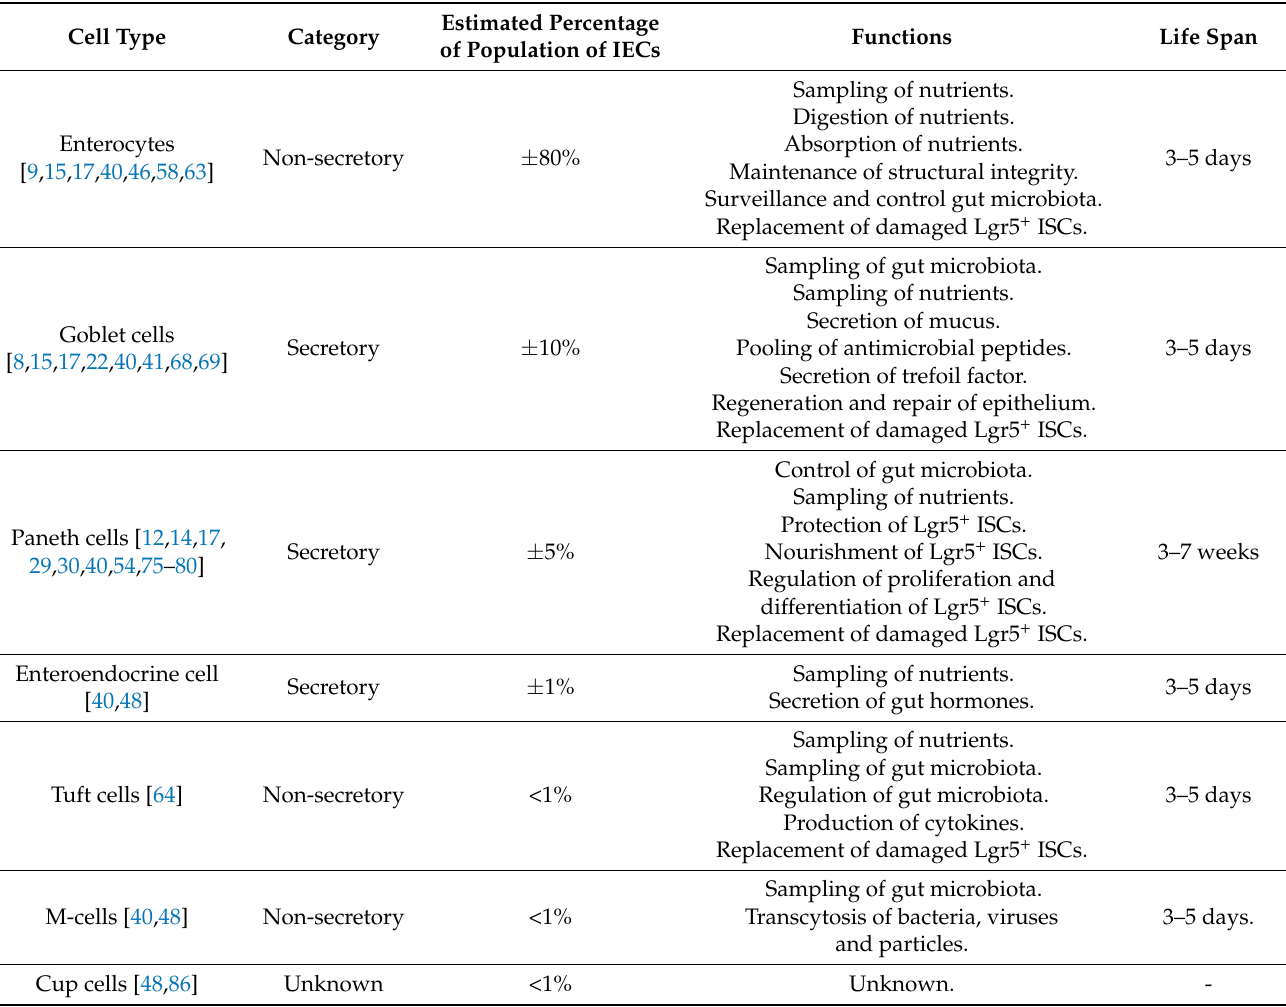
Table 1. Estimate proportional representation of the intestinal epithelial cells of the absorptive and secretory lineages and the roles each cell type plays to support the Lgr5 ISC during a healthy a healthy state and following ionizing